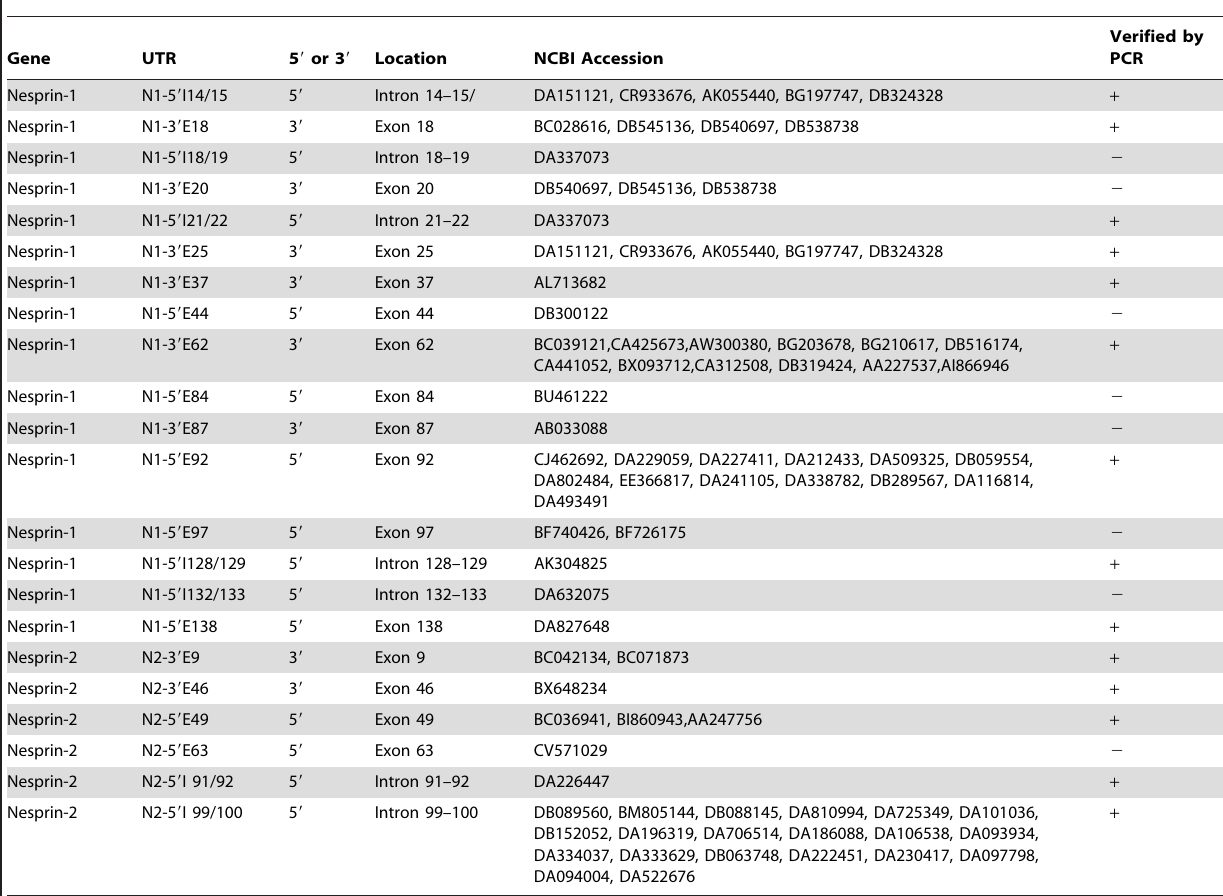
Table listing all potential UTRs identified through available online databases.